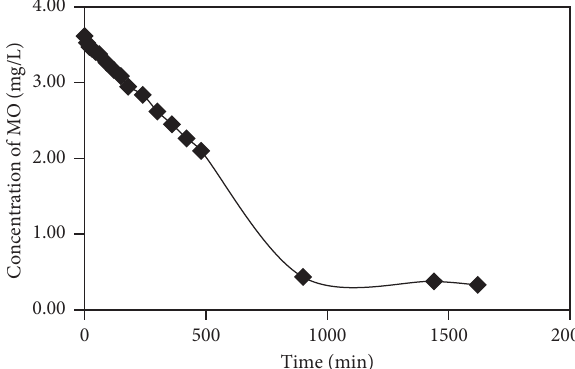
Figure 11: Effect of contact time on reducing adsorbate concen- tration during the adsorption of methyl orange onto cross-linked chitosan